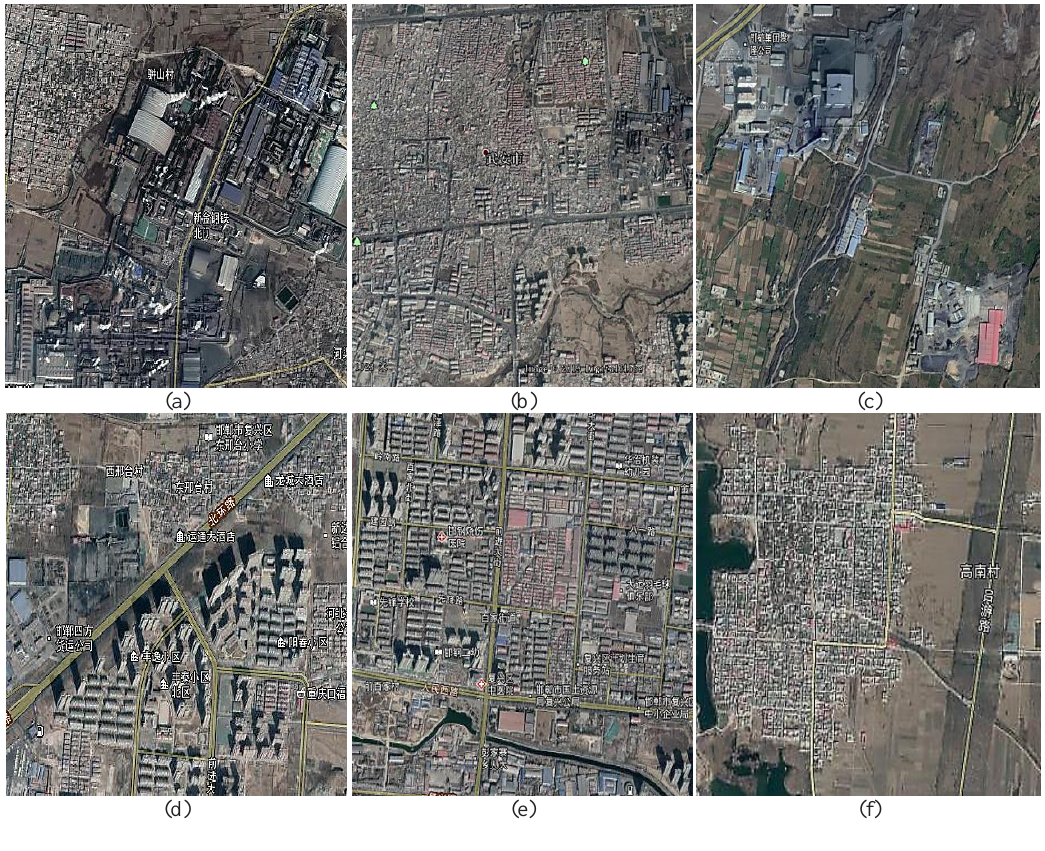
Figure 6. Actual ground